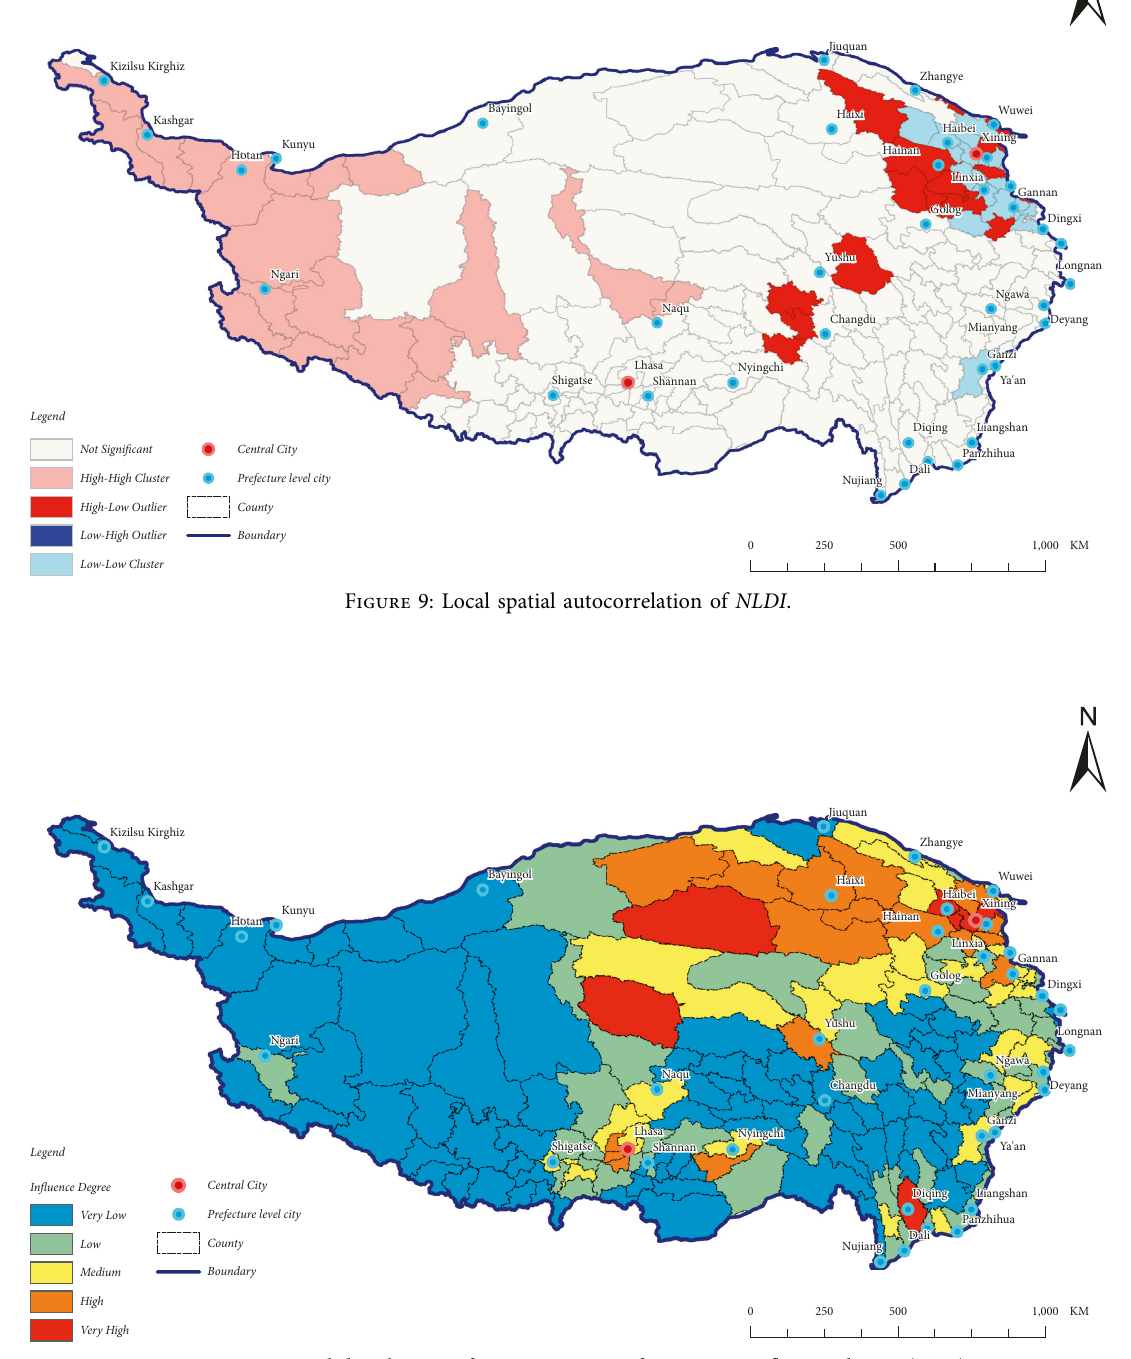
Figure 10: Spatial distribution of transportation infrastructure influence degree ( TIID